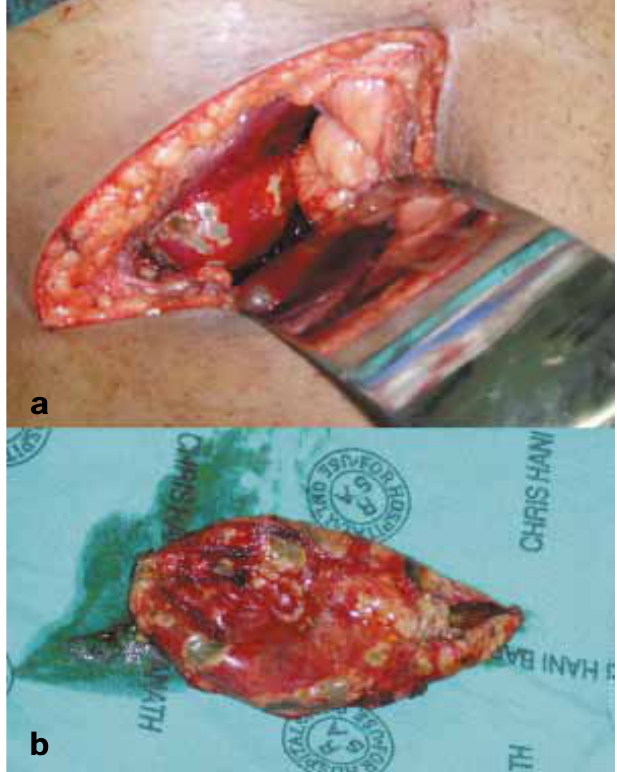
Fig. 2a. Intraoperative image demonstrating the inflamed gallbladder. Fig. 2b. Gross pathological specimen showing necrosis and gangrene of the gallbladder wall. No calculi were present within the